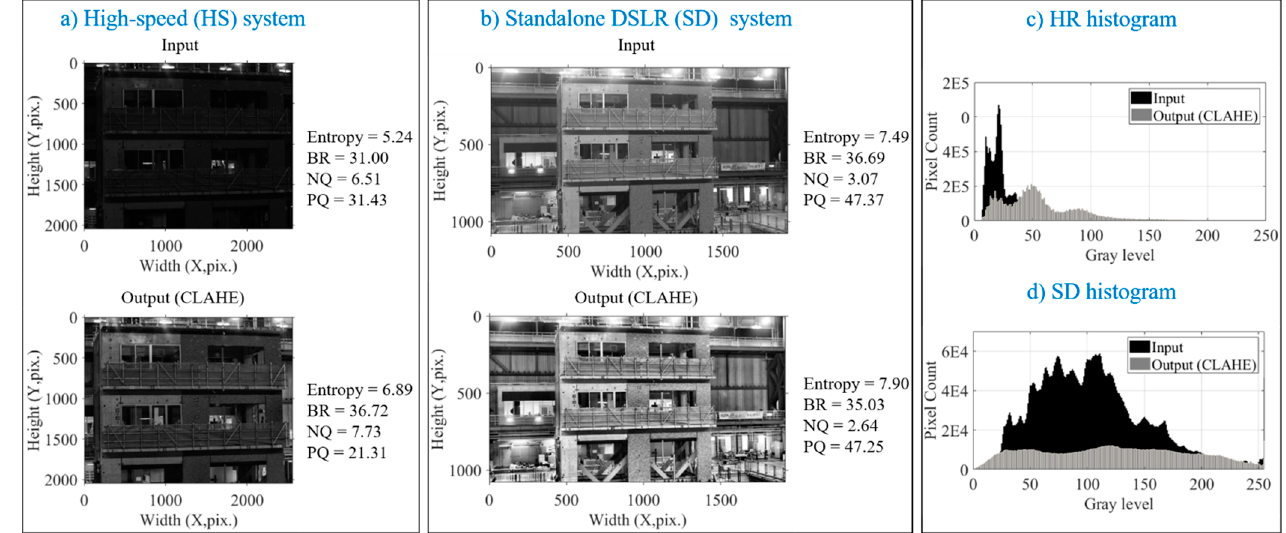
Figure 8. Input and output image with gray level intensity from CLAHE methods.